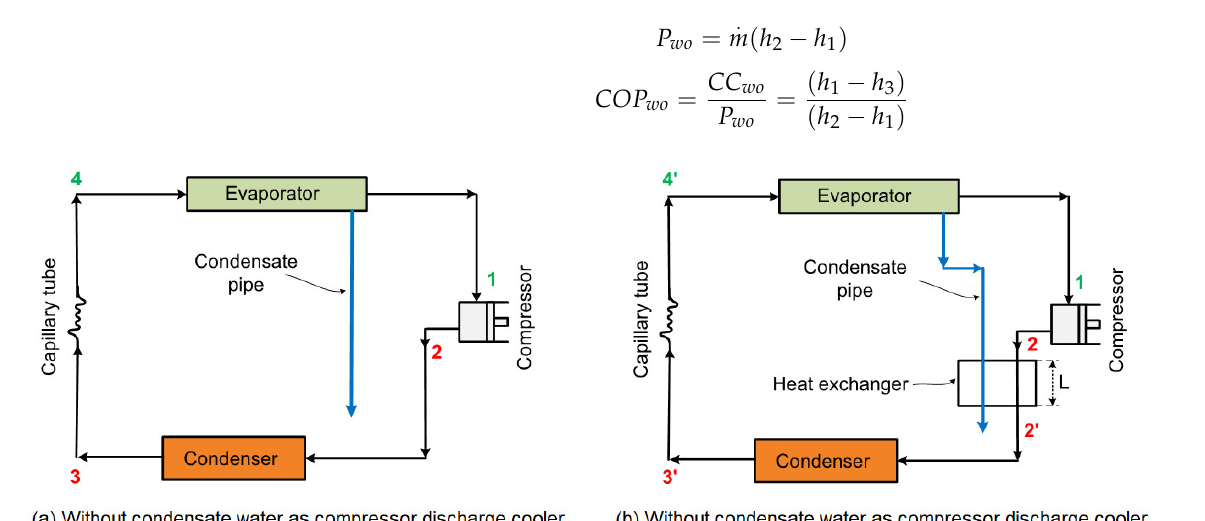
Figure 1. Schematic diagrams of the air-conditioning system.